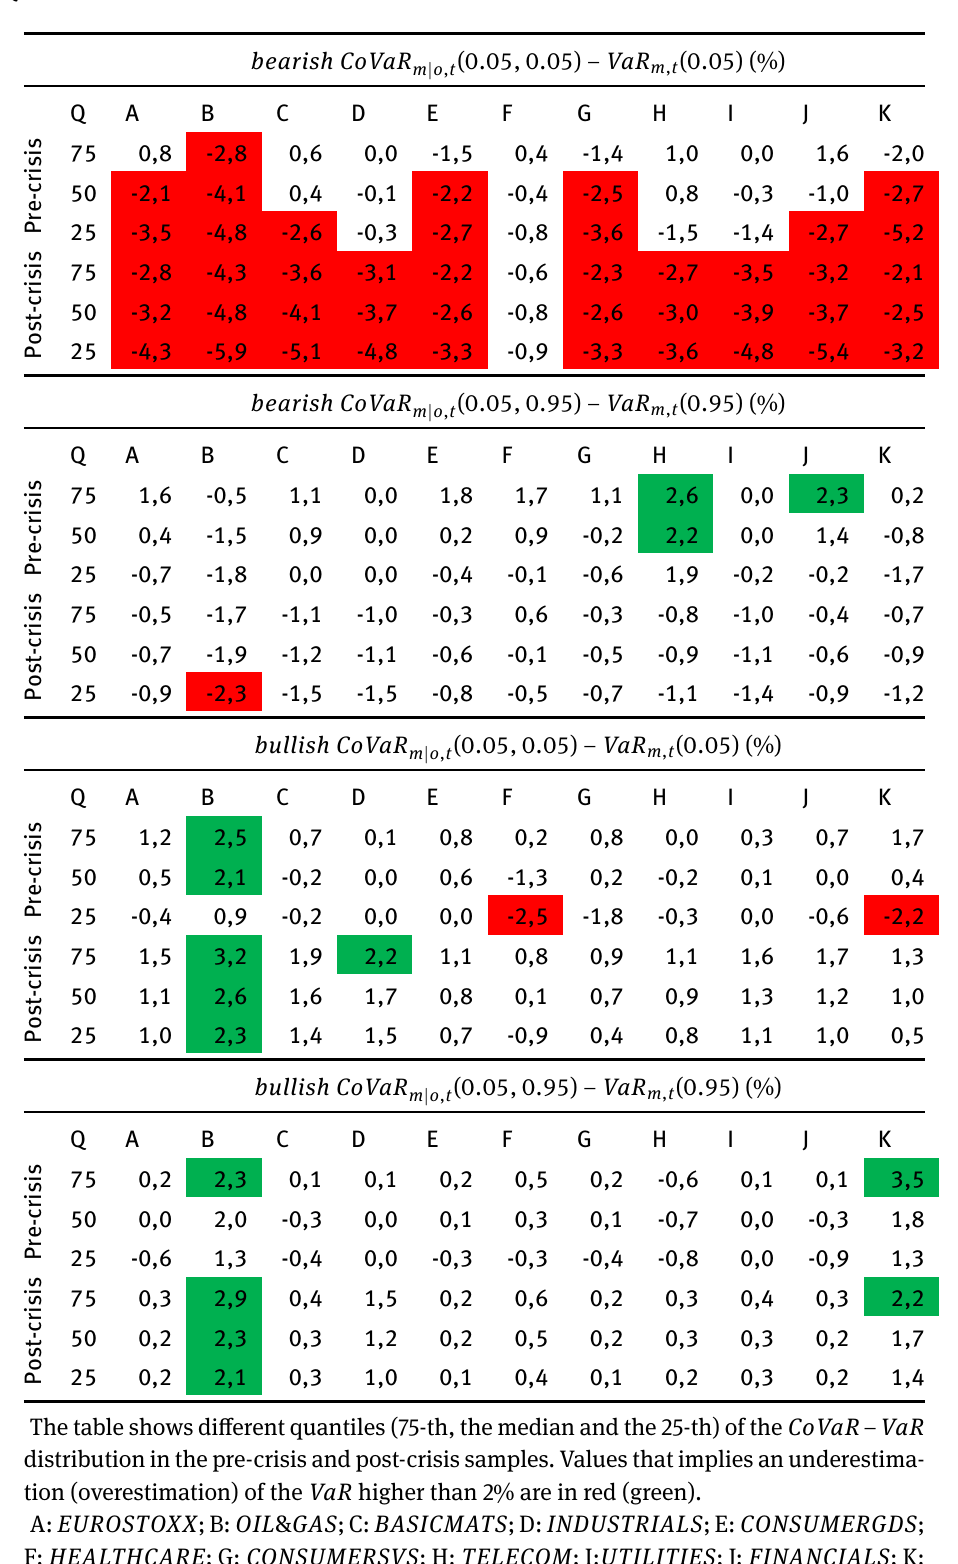
Table 11: Quantiles of the CoVaR − VaR distribution before and after the 2008 financial